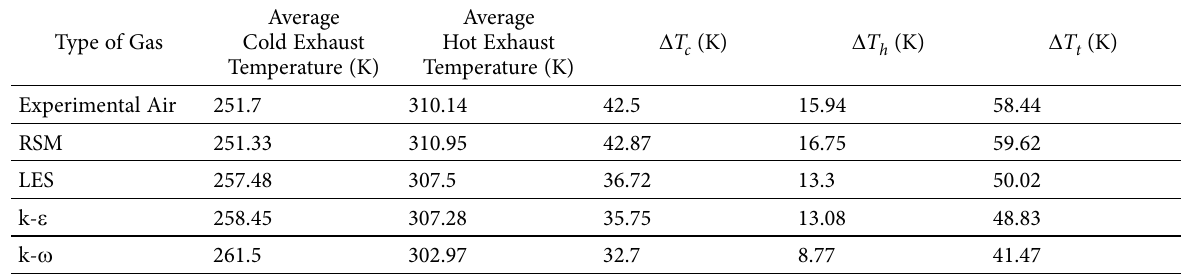
Table 2. Numerical temperature separations regarding different types of the operating turbulence models with the cold mass fraction a =